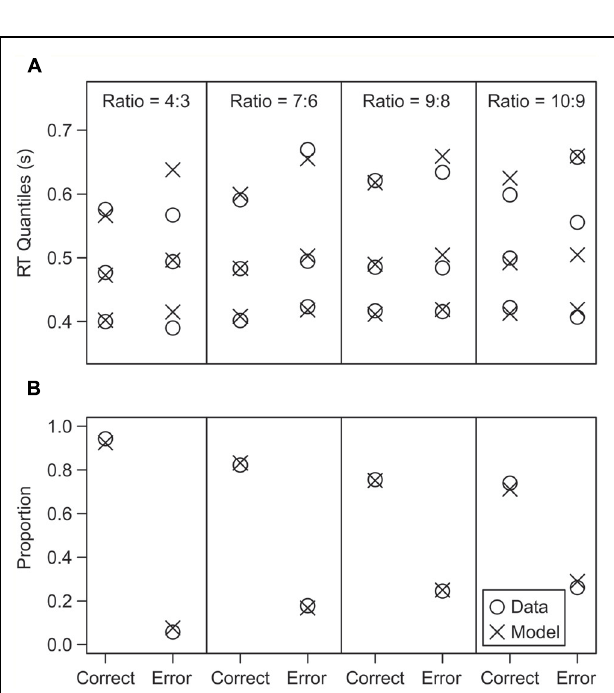
FIGURE 3 | Model fit results of an average participant (specifically, the participant whose fit criterion was closest to the median criterion across all participants). (A) RT quantile fit results. The 0.1, 0.5, and 0.9 quantiles of each RT distribution are displayed (the model was also fit to the 0.3 and 0.7 quantiles, but they were omitted to reduce clutter). (B) Proportion fit results.